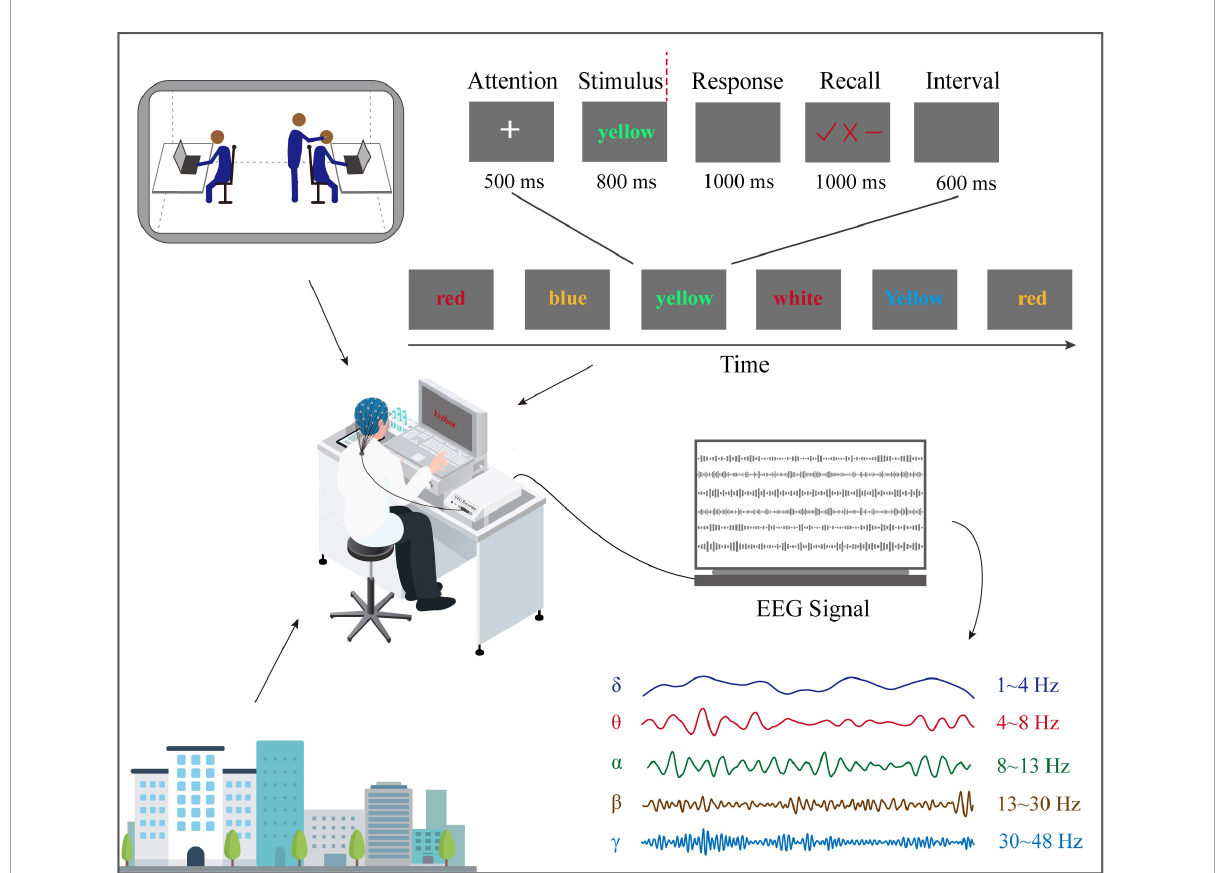
FIGURE1 Experiment and task design. When volunteers and pilots perform double-choice oddball tasks on the ground or flight environment, EEG was recorded at the same